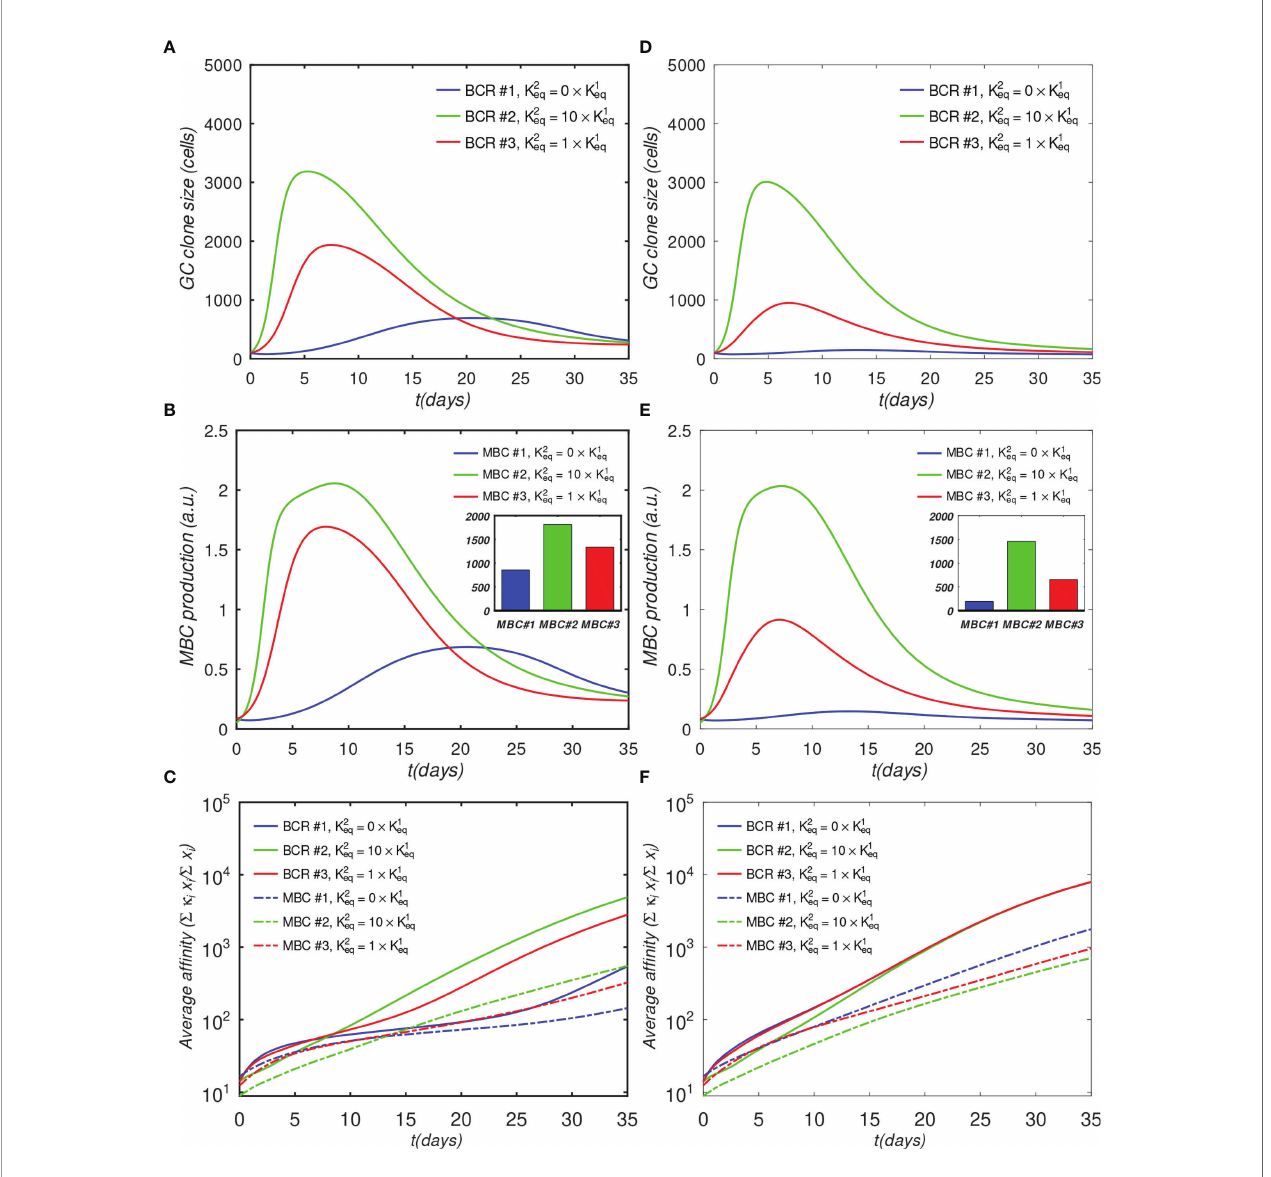
FIGURE 4 | Effect of antibody valency and epitope occlusion on GC properties. Left column (A – C) noninteracting B-cell case ( o = 0); Right column (D – F) fully interacting B-cell case ( o = 1); (A, D) Total B cells; (B, E) Memory cell production rate; insets: total MBC population at end of simulation; (C, F) Average af fi nity of B-cells and MBCs. For the de fi nition of occlusion o, see Sec. 4.1.5